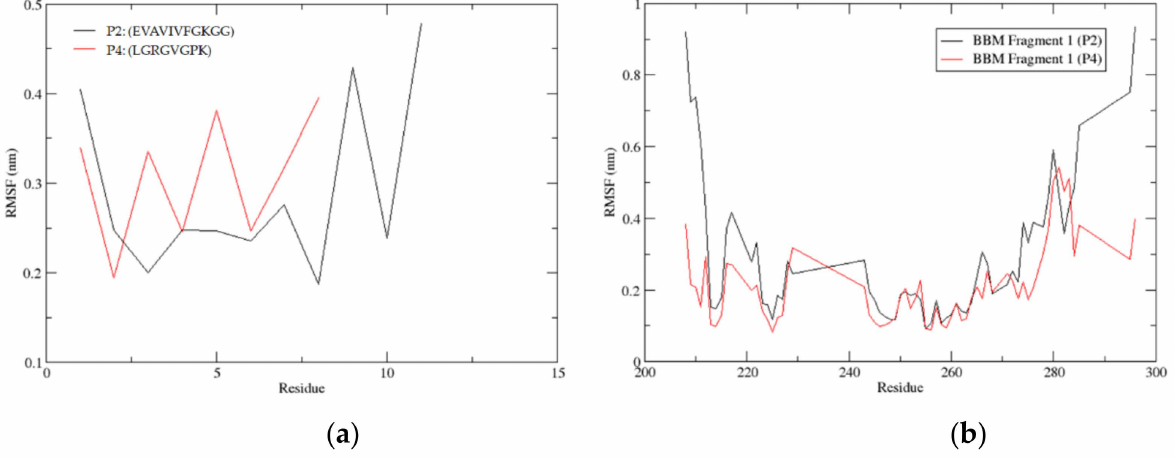
Figure 9. ( a ) Root mean square fluctuation (RMSF) for peptide in protein-peptide complexes with P2 (dock10) and P4. ( b ) Root mean square fluctuation (RMSF) for residue of BBM Fragment 1. Figures are generated using xmgrace tool of linux.